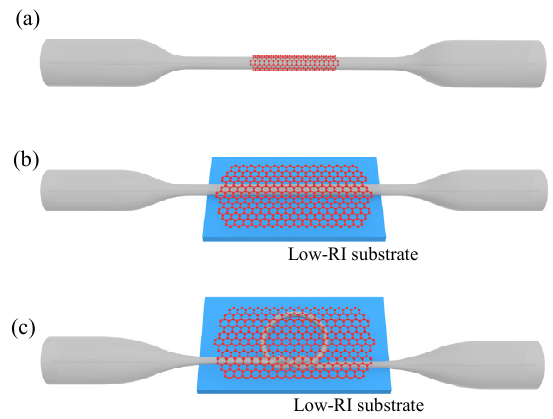
Fig. 6 Graphene functionalized optical fiber platform, presented as an example. Functional materials can be integrated with (a) a free-standing microfiber, (b) a microfiber on a low-RI substrate, and (c) a microfiber knot resonator on a low-RI